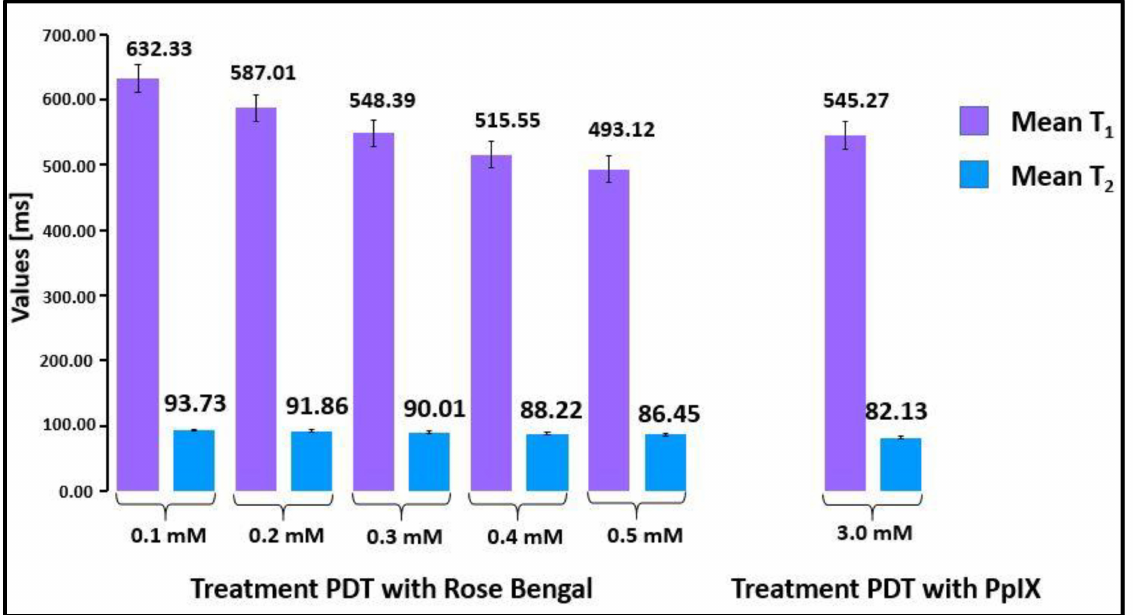
Figure 3. Mean values of T 1 and T 2 relaxation times for tissue treated with RB and PpIX. The difference in mean T 1 and T 2 relaxation times prior to and post PDT is statistically significant ( p < 0.03). For comparison, the relaxation times measured for deionized water were T 1 = 3245.45 ± 23 ms and T 2 = 134.23 ± 11 ms. For 0.5 mM Rose Bengal, T 1 = 2994.68 ± 10 ms and T 2 = 129.32 ± 9